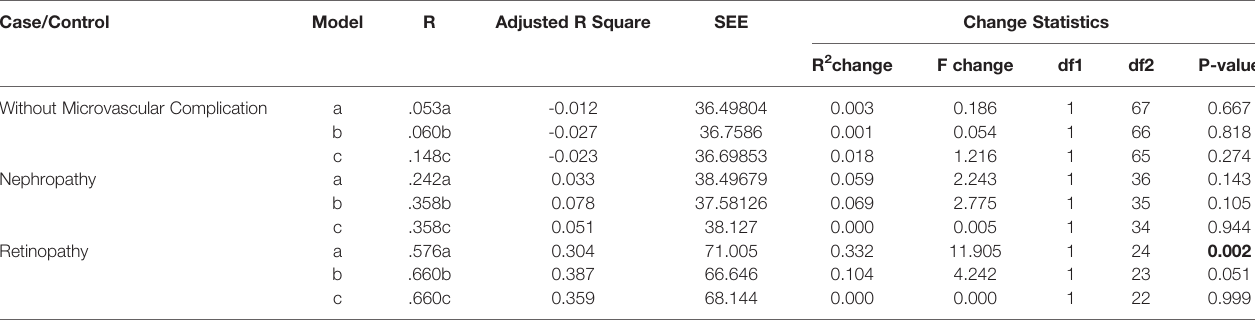
TABLE 4 | Multiple regression analysis (Stepwise) to evaluate the relationship between serum sialic acid and metabolic analytes within the groups (retinopathy, nephropathy, and those without microvascular complication. Case/Control Model R Adjusted R Square SEE Change Statistics